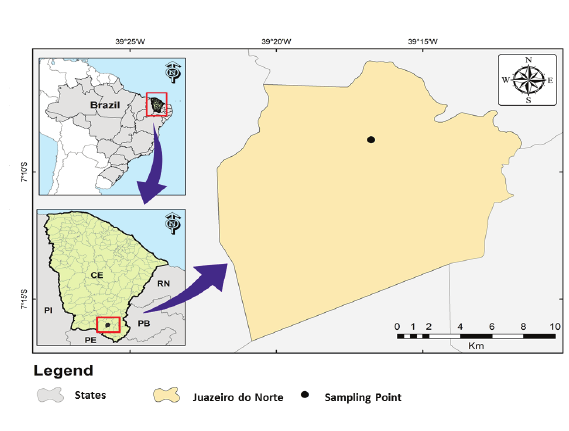
Figure 1 - ‘Map of the municipality of Juazeiro do Norte, northeastern Brazil, Black spot: sampling site (7° 08’ 44.64” S, 39° 16’ 45.37”